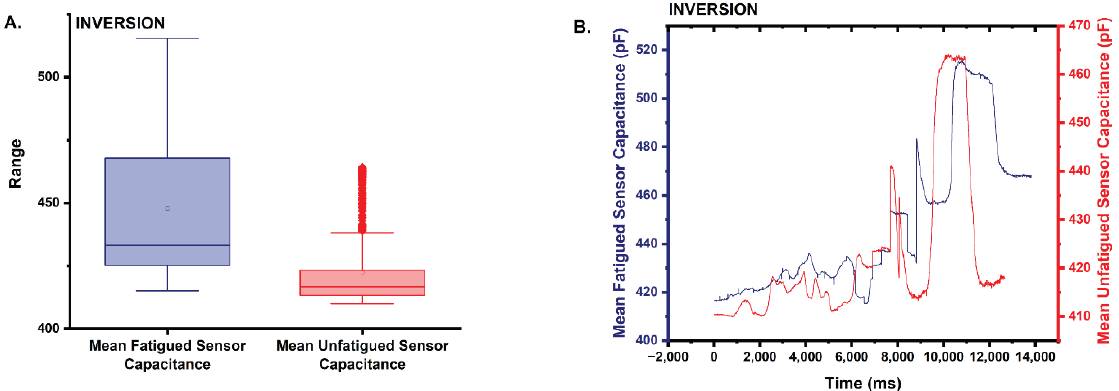
Figure 11. ( A ) Box plot of the statistics comparing the mean capacitance of the fatigued sensor to that of the unfatigued sensor in inversion. Note that the mean capacitance is higher for the fatigued sensor. ( B ) Plot comparing the mean capacitance of the fatigued sensor to the unfatigued sensor during the inversion trials.